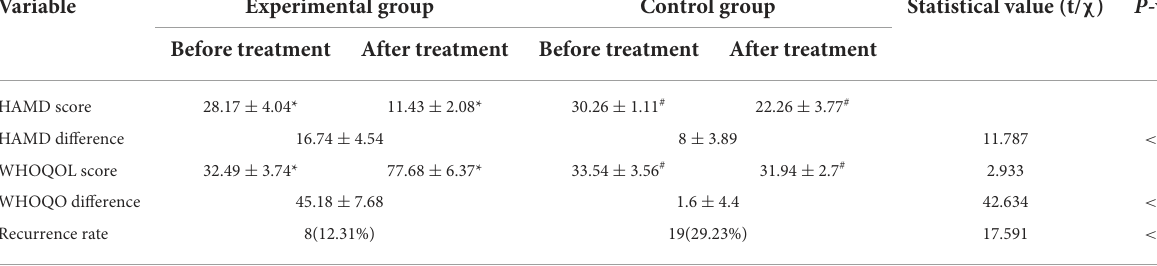
TABLE 2 Comparison of clinical data between the two groups after acute phase treatment and MBCT. Variable Experimental